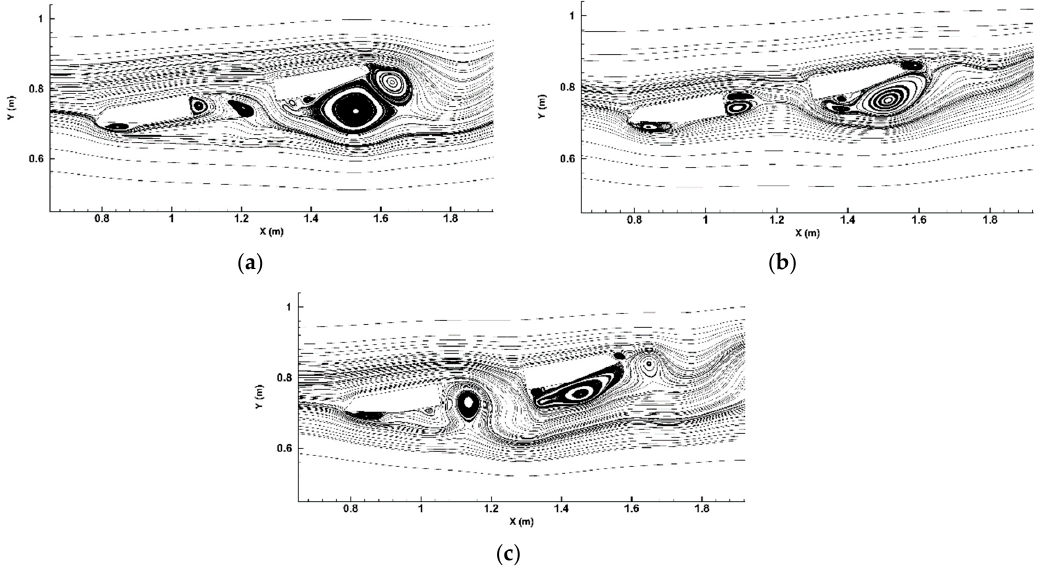
Figure 13. Instantaneous streamlines of AoA = − 10.0 ◦ at ( a ) tU ∞ / D = 272 and 2 tU ∞ / b = 62, ( b ) tU ∞ / D = 304 and 2 tU ∞ / b = 69, and ( c ) tU ∞ / D = 328 and 2 tU ∞ / b = 75.